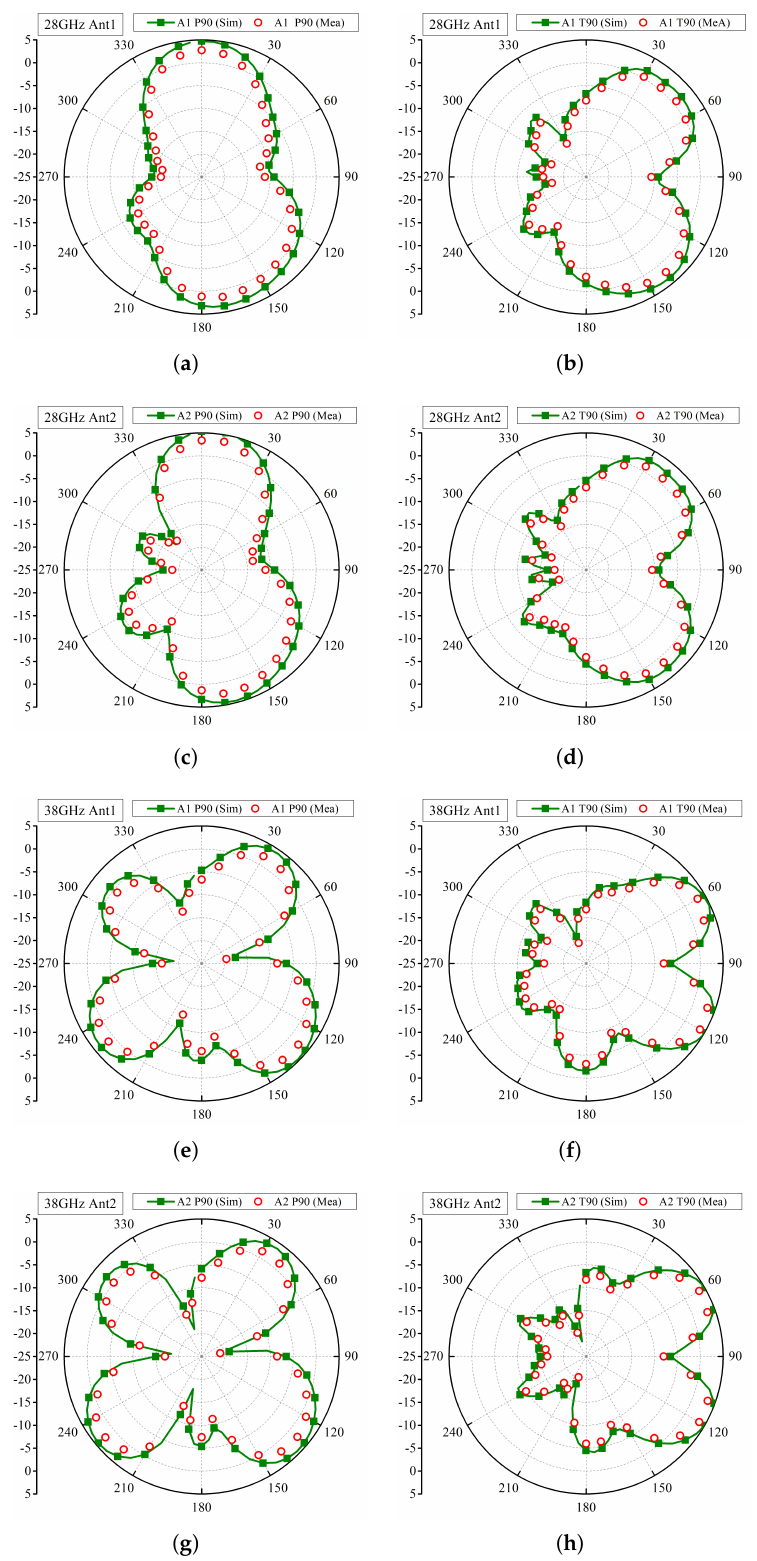
Figure 11. Olympeak MIMO antenna radiation pattern ( a ) Antenna 1 28 GHz Phi 90 ( b ) Antenna 1 28 GHz Theta 90 ( c ) Antenna 2 28 GHz Phi 90 ( d ) Antenna 2 28 GHz Theta 90 ( e ) Antenna 1 38 GHz Phi 90 ( f ) Antenna 1 38 GHz Theta 90 ( g ) Antenna 2 38 GHz Phi 90 ( h ) Antenna 2 38 GHz Theta